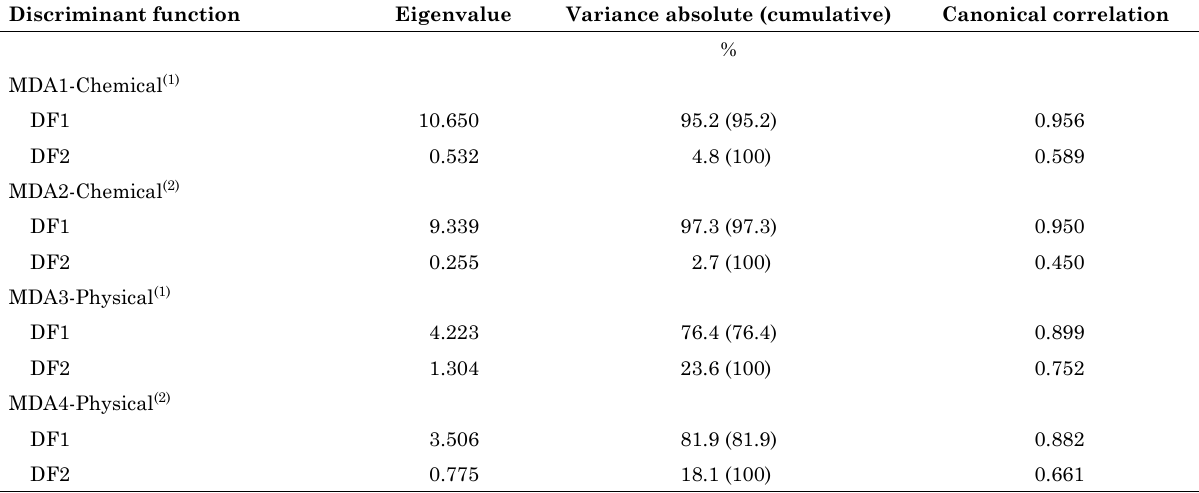
Table 4. Summary of descriptive fisher’s discriminant model Discriminant